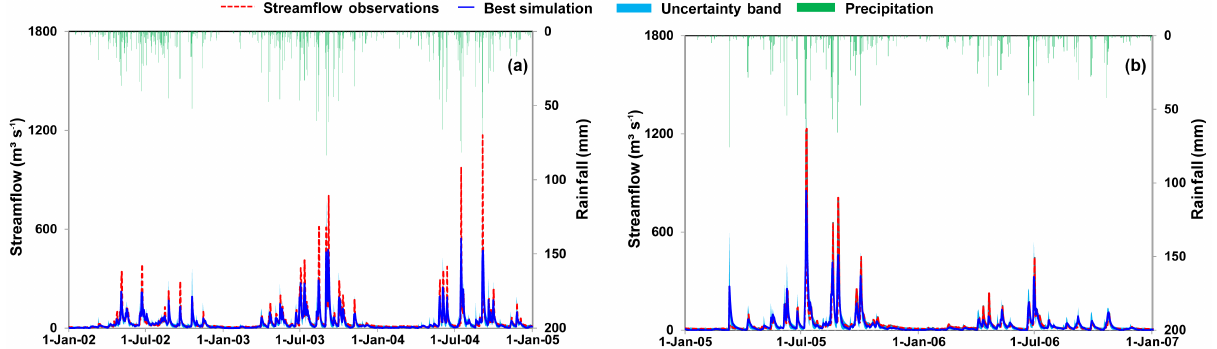
Figure 3. Simulated streamflow for the benchmark calibration of the Donghe Basin in both the calibration (2002–2004) and validation (2005–2006)